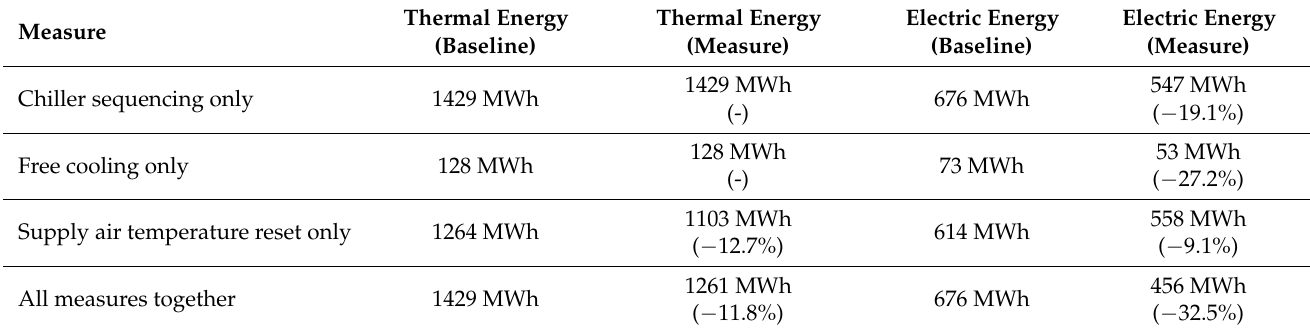
Table 4. Performance of proposed data-driven